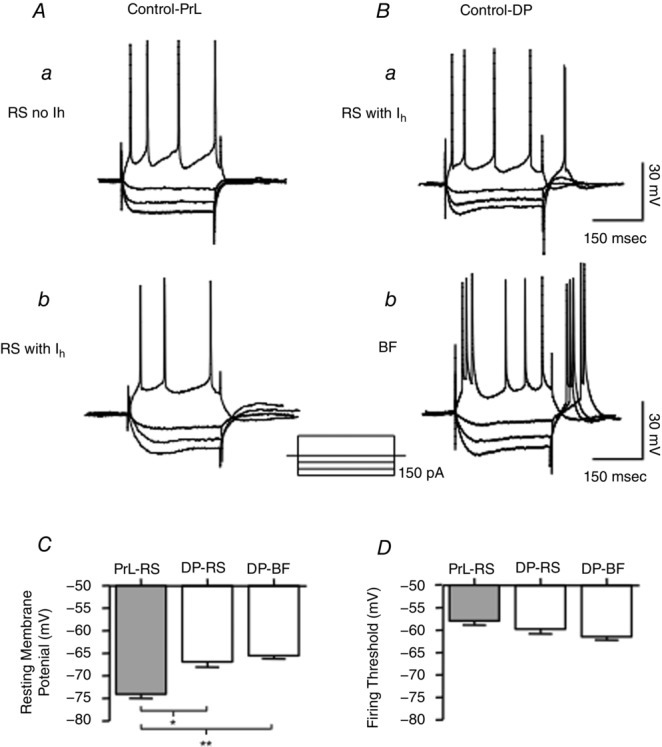
Intrinsic cell properties in the absence of network oscillationsMembrane response of presumed pyramidal cells in PrL (A) and DP (B) regions to hyperpolarizing and depolarizing current pulses (300 ms, 50 pA current steps) in normal ACSF (no Cb–KA-evoked oscillations) of an RS cell without Ih (Aa) and an RS cell with Ih (Ab) in the PrL. B, membrane responses of an RS cell with Ih (Ba) and a BF cell in the DP under the same recording protocol as in A (Bb). C, barplots showing the significant difference in the resting membrane potential (P < 0.001, one-way ANOVA, Tukey's test, PrL: nRS = 20, DP: nRS = 9, nBF = 8). D, barplots illustrating the mean firing threshold values (P > 0.05, one-way ANOVA, PrL: nRS = 20, DP: nRS = 9, nBF = 8) for RS and BF cells in the mPFC.